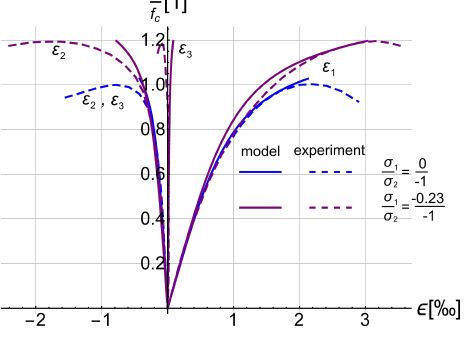
Figure 3. Comparison of theoretical and experimental curves σ − (cid:101)